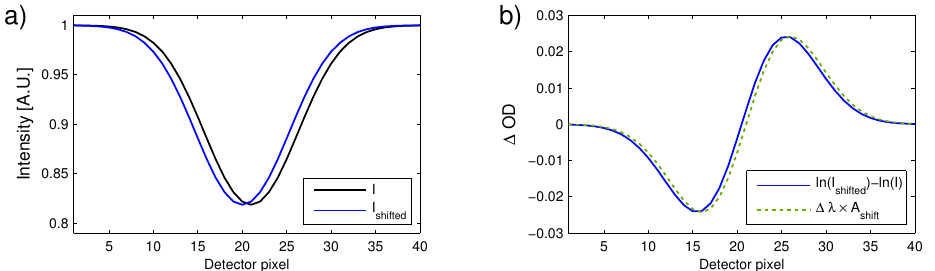
Fig. 1. Illustration of the effect of a spectral shift of I . (a) Original (black) and shifted (blue) Intensity I in artificial units, showing a single absorption line according to Eq. (7), with an optical depth of a = 0 . 2 and a width ς of 5 pixel, for a shift of 1λ = 1 pixel. (b) Actual difference of the true and shifted OD (blue), compared to the linear approximation, i.e., the pseudo-absorber A Shift as defined in Eq. (4), scaled by the applied shift of 1 pixel (green).